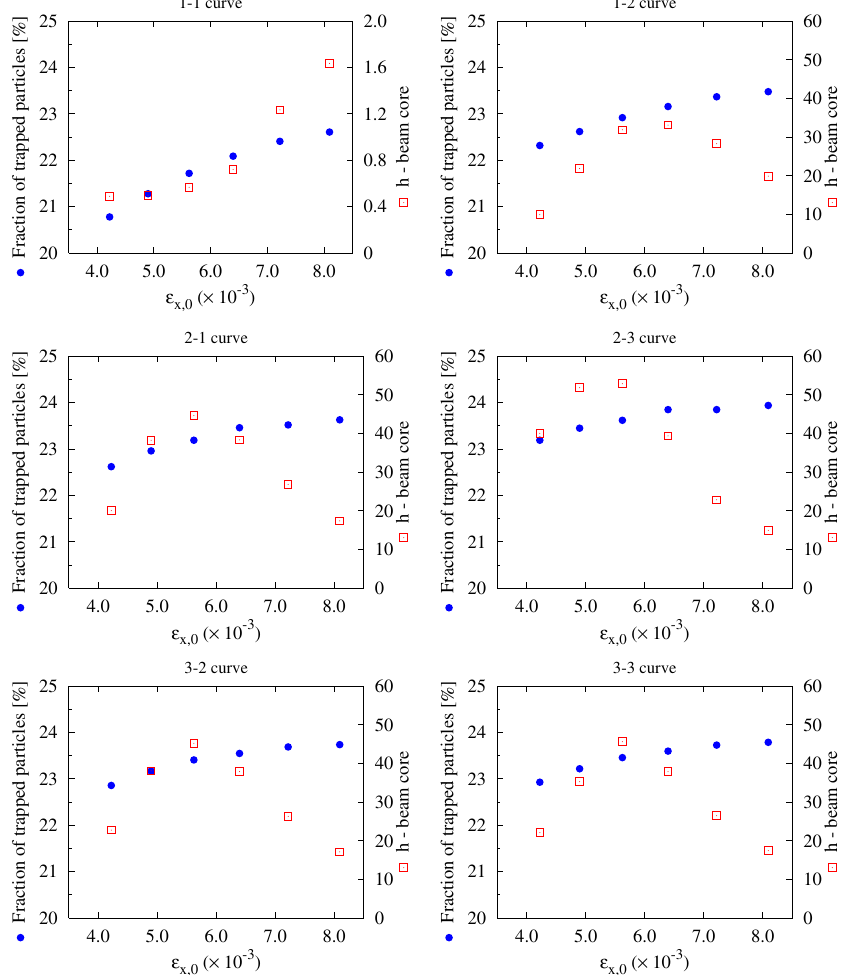
FIG. 5. (Color) Fraction of trapped particles as a function of the initial emittance. Six types of tune curves are used (marked on top of each plot). The value of the factor h for the beam core after splitting is also